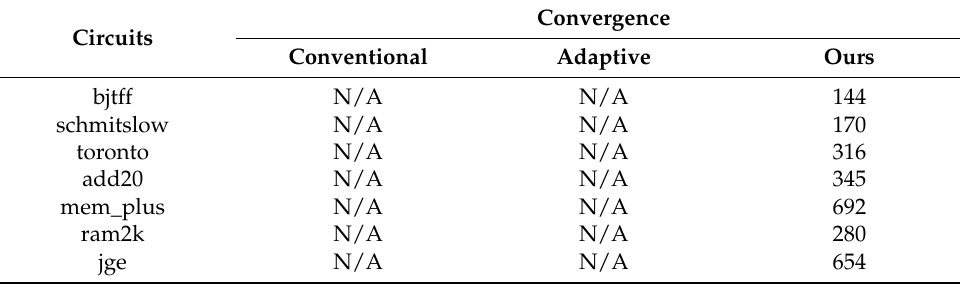
Table 5. Improvement convergence for DPTA on some